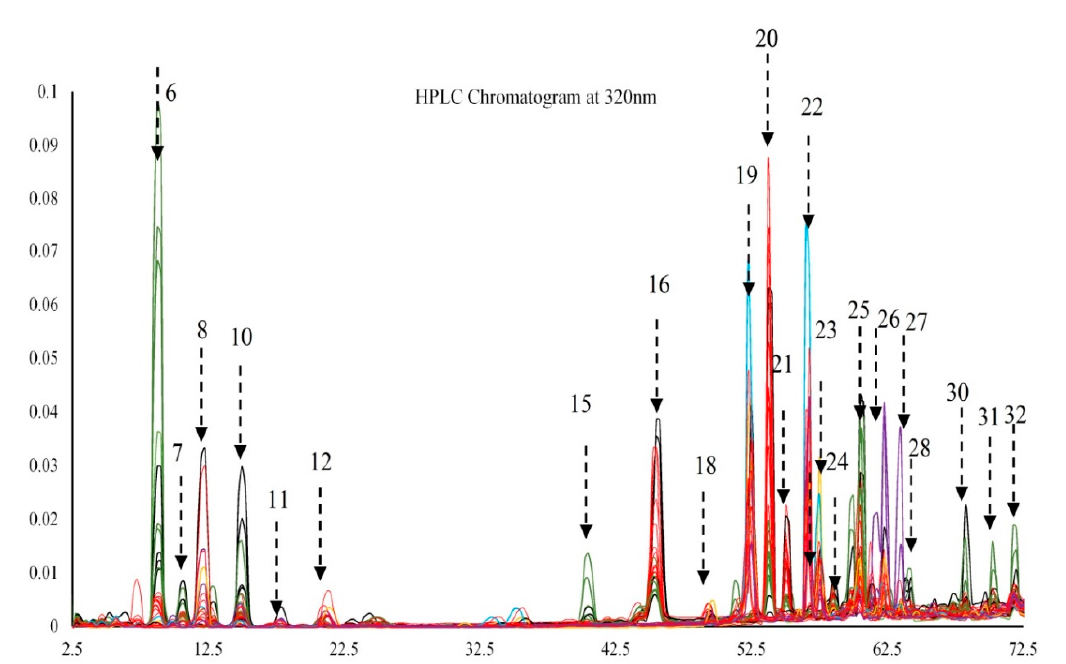
Figure 1. Phenolic chromatogram observed at 280 nm and 320 nm obtained for all the monocultivar EVOOs studied. Di ff erent colors represent olive oils derived from di ff erent geographical origin. Black = indigenous Maltese cultivars; green = foreign cultivars that are locally grown; red = Italian cultivars; blue = Greek origin; purple = French origin and yellow = Spanish origin.